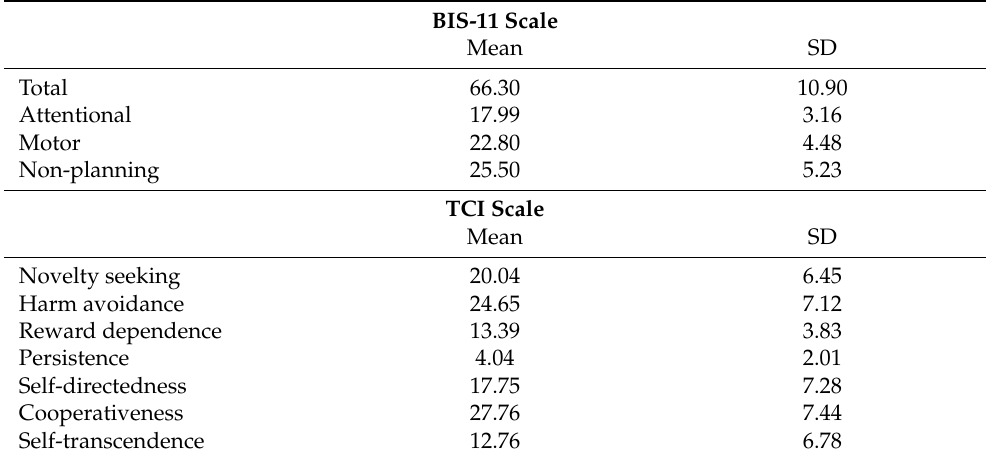
Table 2. Mean BIS-11 and TCI dimensions from the study